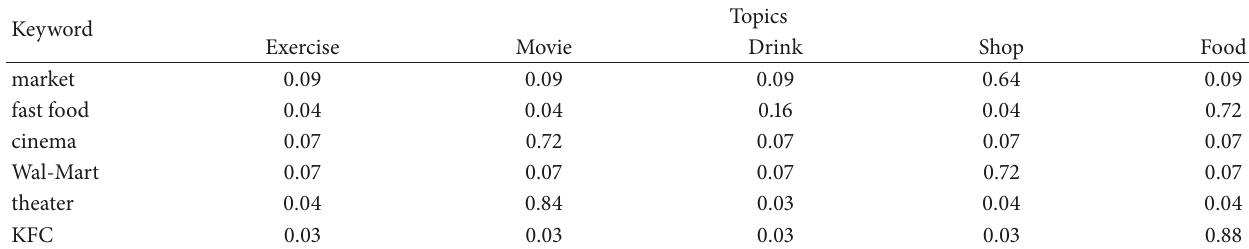
Table 3: Topic distributions of textual descriptions.